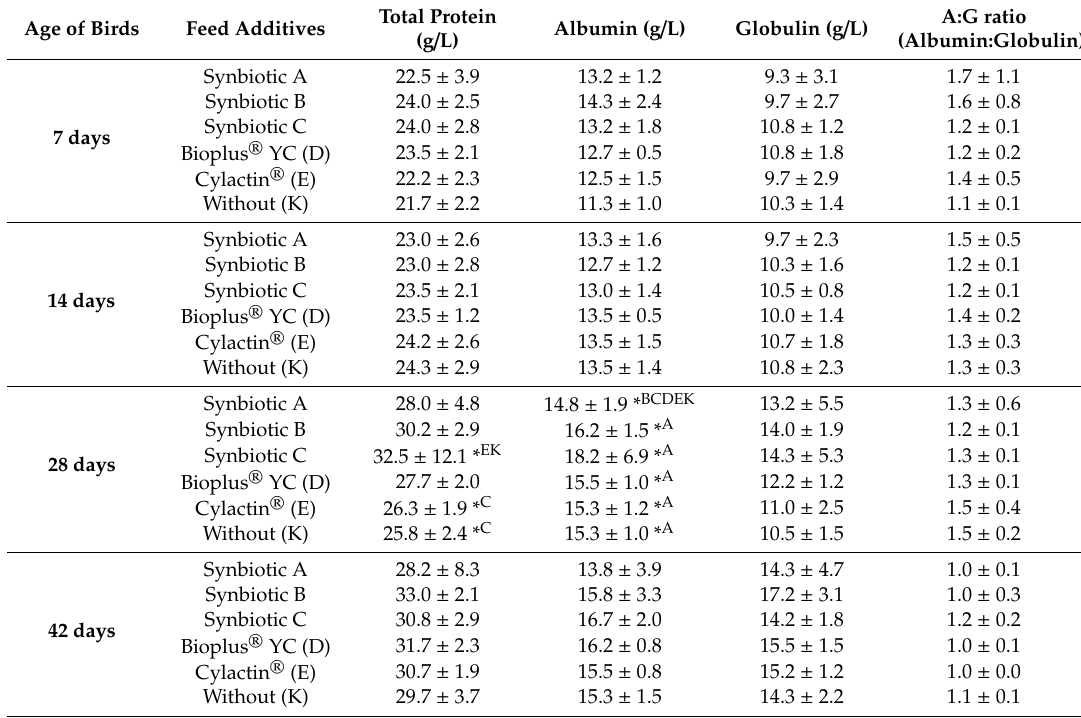
Table 6. Concentrations of the tested parameters in the blood serum of the experimental chickens. *—statistically significant di ff erences between groups, p ≤ 0.05.